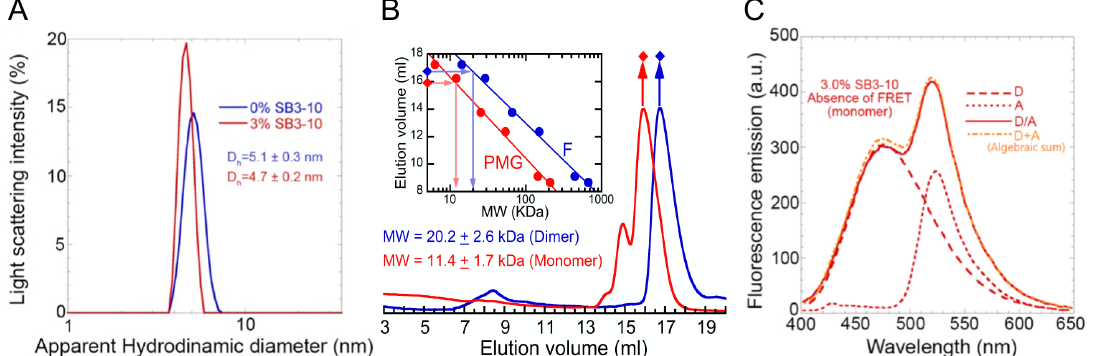
Figure 3. Oligomeric state characterization of TDP-43 NTD. DLS distributions ( A ), analytical size exclusion chromatography (SEC) profiles ( B ) and FRET analyses ( C ) of TDP-43 NTD in 0.0% (blue) and 3.0% (red) SB3-10. All SB3-10 percentages are w/v . In panel ( B ) the inset shows the calibration curve obtained with proteins of known masses (blue) and re-determined mathematically for pre- molten globule states, as described in Methods (red). In panel ( C ) the spectra refer to NTD-D (dashed line), NTD-A (dotted line), NTD-D/NTD-A (continuous line) and the algebraic sum of the first two spectra (mixed orange dotted/dashed line). The writings inside the panels indicate the values obtained for the analysed parameters.